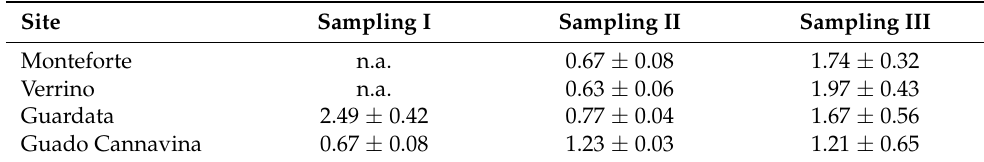
Table 1. Condensed tannin concentration in extracts of F. circummediterranea collected during the three sampling times in the four study areas. Results are expressed as µ g mL − 1 . Standard deviation values are reported. n.a. means that the sample was not